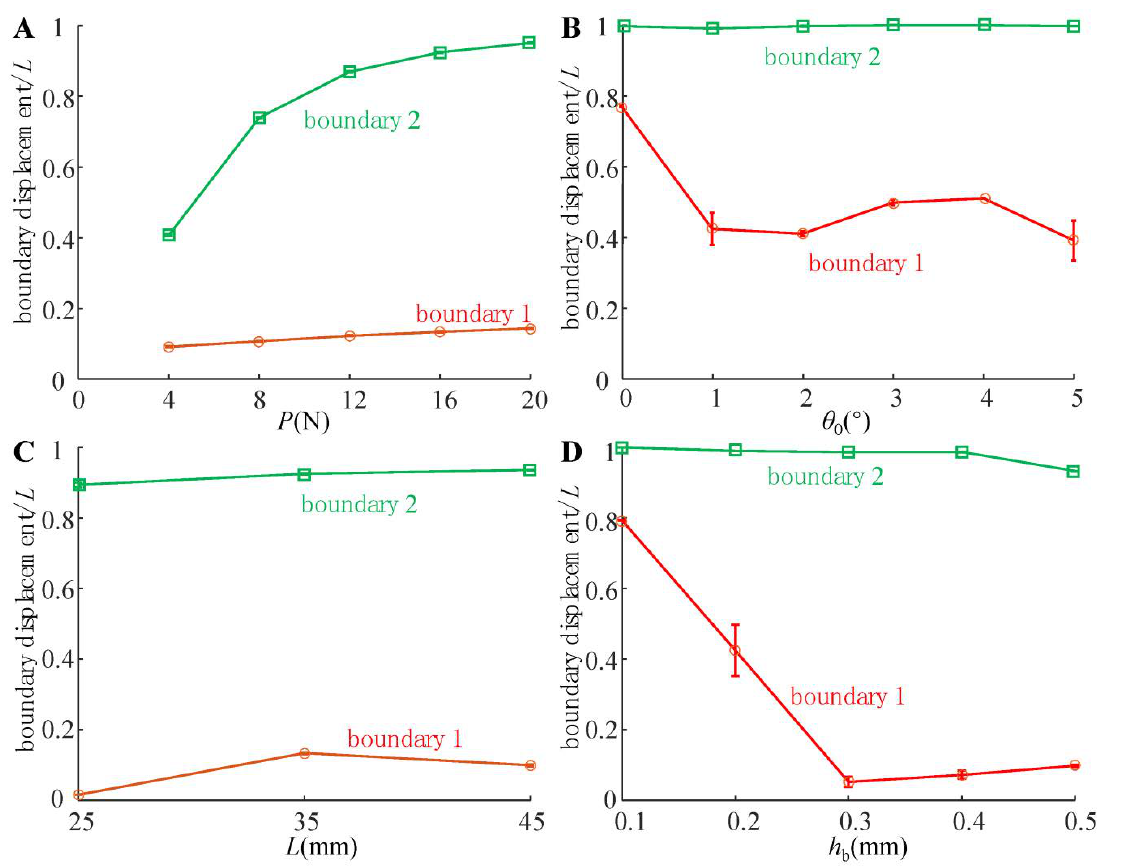
Figure 6. Boundary displacement of the adhesive unit for different ( A ) compression force P , ( B ) angle of inclination θ 0 , ( C ) unit length L , ( D ) and thickness of RBL h b